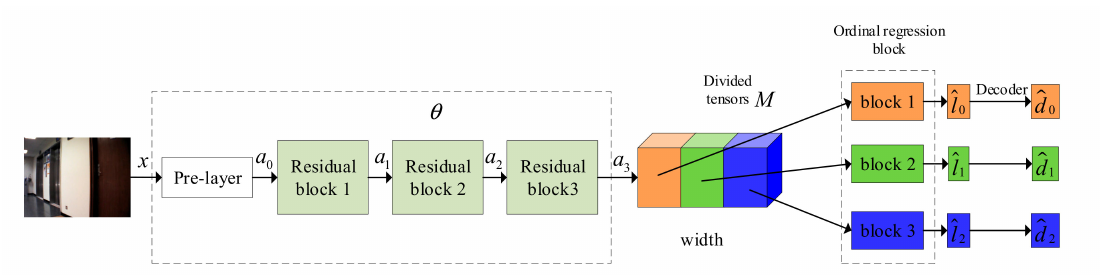
Figure 2. The non-uniform spacing-increasing discretization-based ordinal regression (NSIDOR)-net framework.